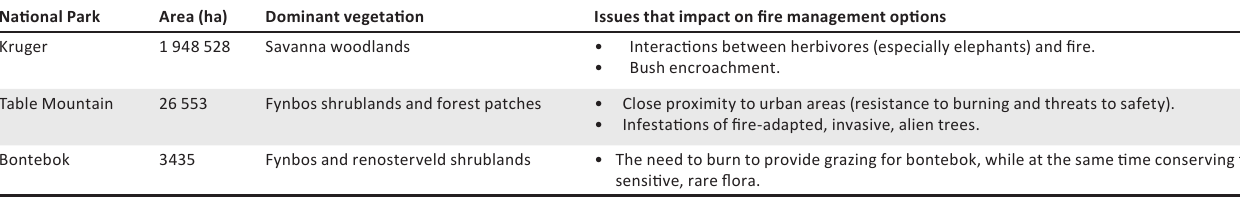
TABLE 1: Salient features of three national parks to which adaptive approaches to fire management have been introduced. National Park Area (ha)